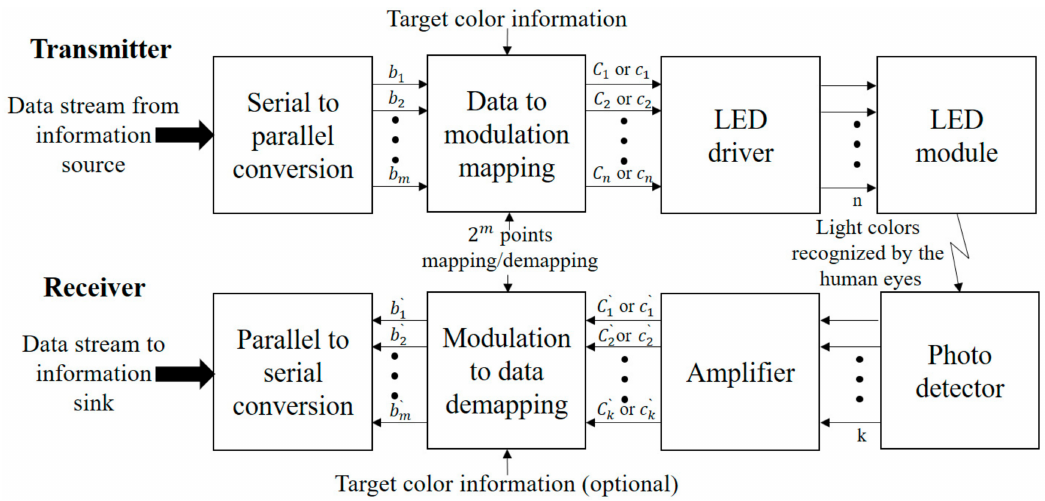
Figure 4. System representation of a color-space-based modulation (CSBM)-based VLC [13]. Additive white Gaussian noise (AWGN) is assumed as channel noise. Typically, it is caused by background lighting that can interfere with the VLC signal. Optical filters can be useful for minimizing the noise, but even if the receiver is well designed, there may still be shot noise. On the receiver side, three PDs with three RGB filters were used to detect the light. To obtain the target color on the receiver side, the following cases are considered